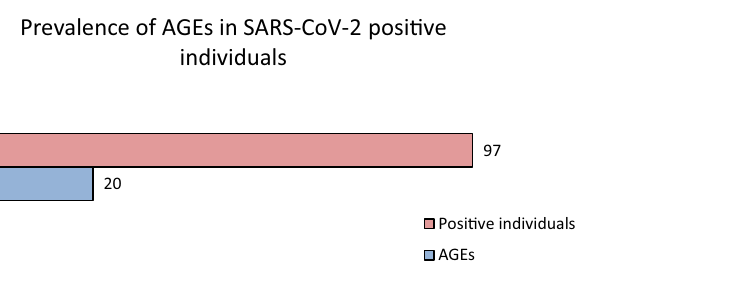
Figure 3. Distribution of AGEs in SARS-CoV-2 positive individuals.